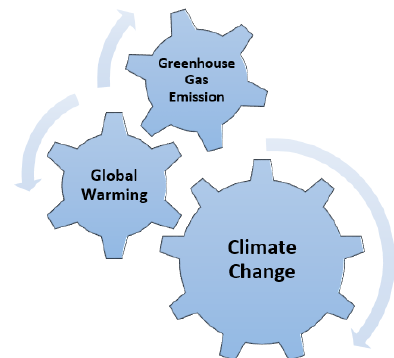
Figure 2. The interrelation between GHG emission, global warming, and climate